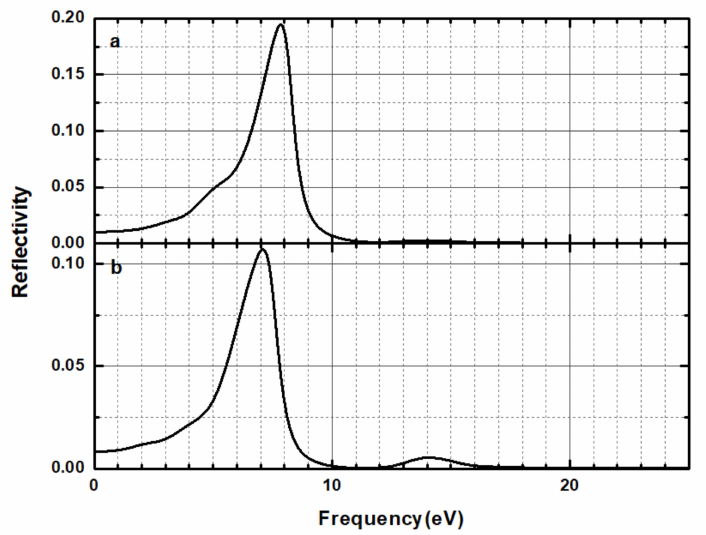
Figure 13. Reflectivity of the CsI(Na) (010) surface ( a ) and that of the CsI(Na) (010) surface adsorbing H 2 O molecules ( b